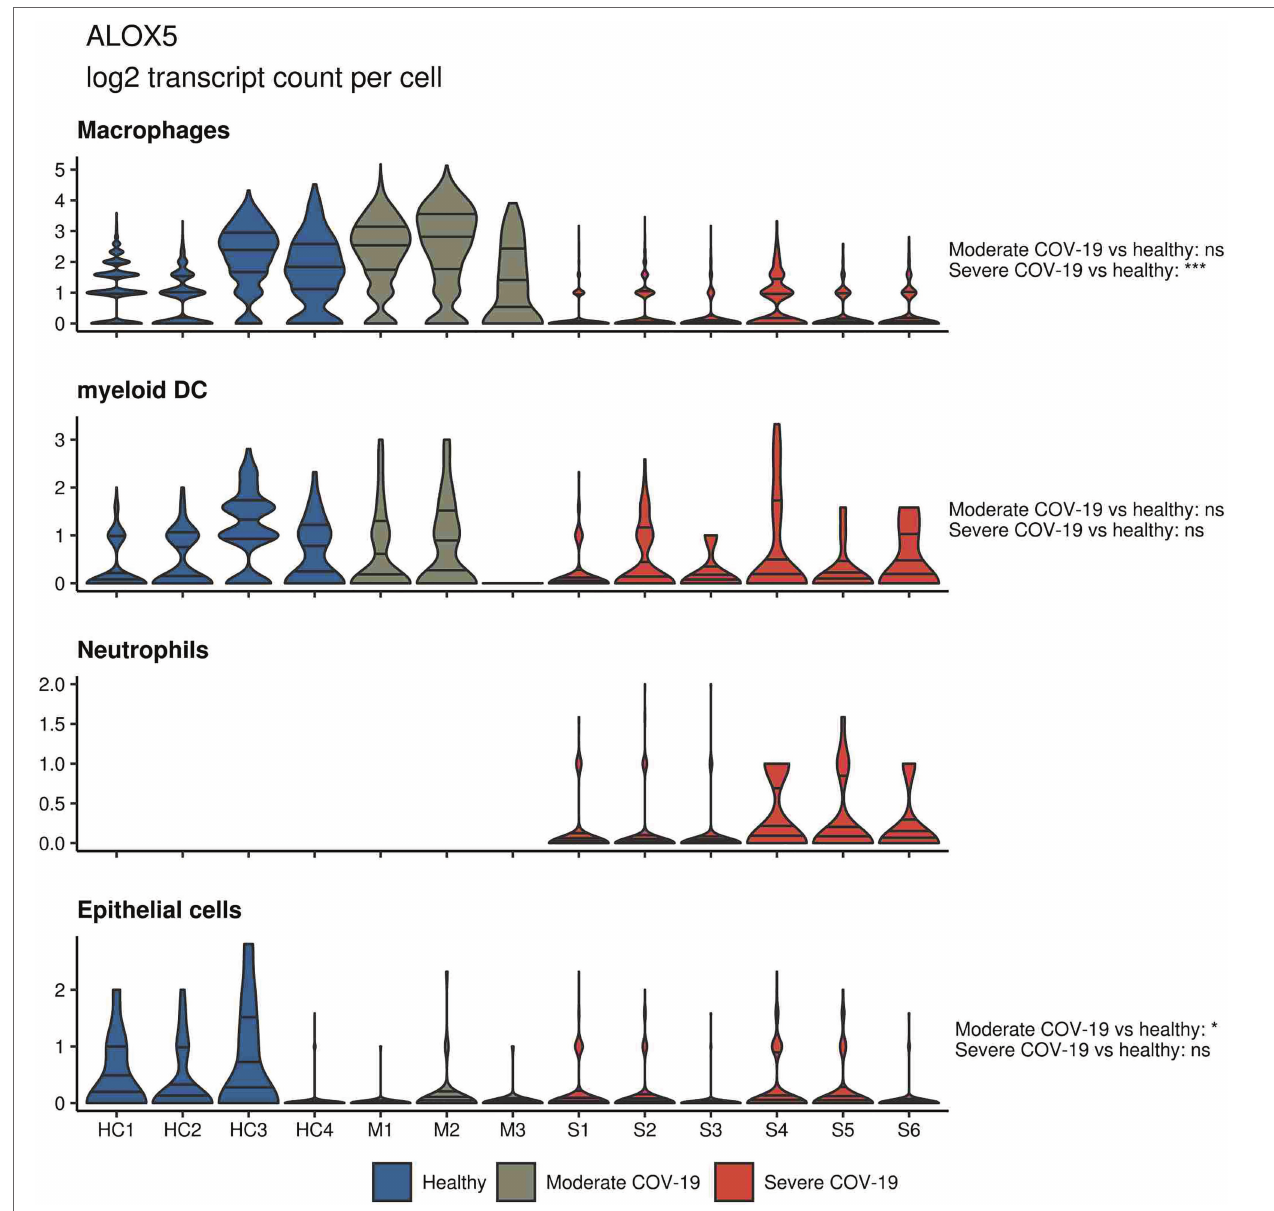
FIGURE 2 | ALOX5 expression in bronchoalveolar lavage fluid (BALF) cells from patients affected by COVID-19. Violin plots depicting ALOX5 expression levels within specific cellular populations in BALF cells from healthy (blue, n = 4), moderate (gray, n = 3), or severe (red, n = 6) COVID-19 patients. RNA sequencing data are publicly available (Liao et al., 2020). ns = non-significant, *** p <